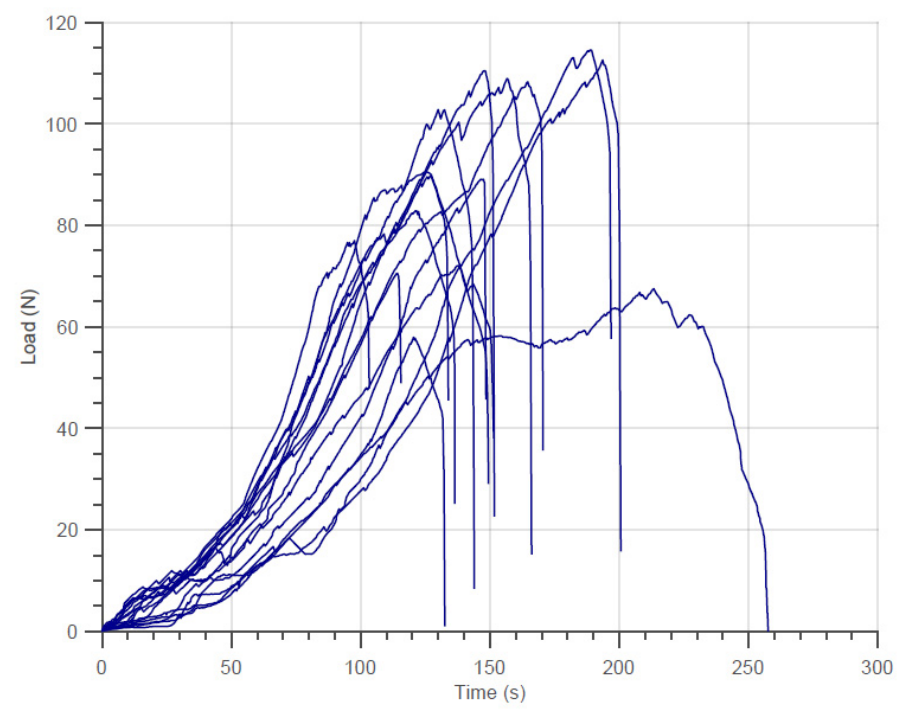
Figure 6. Examples of Tensile Tests on N610 with 750 fibers bundles. Table 4. Average rupture signal amounts and standard deviation for the different fiber types and initial amount of